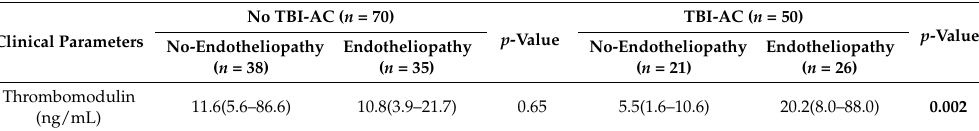
Table 3. Glycocalyx shedding and endothelial disruption.